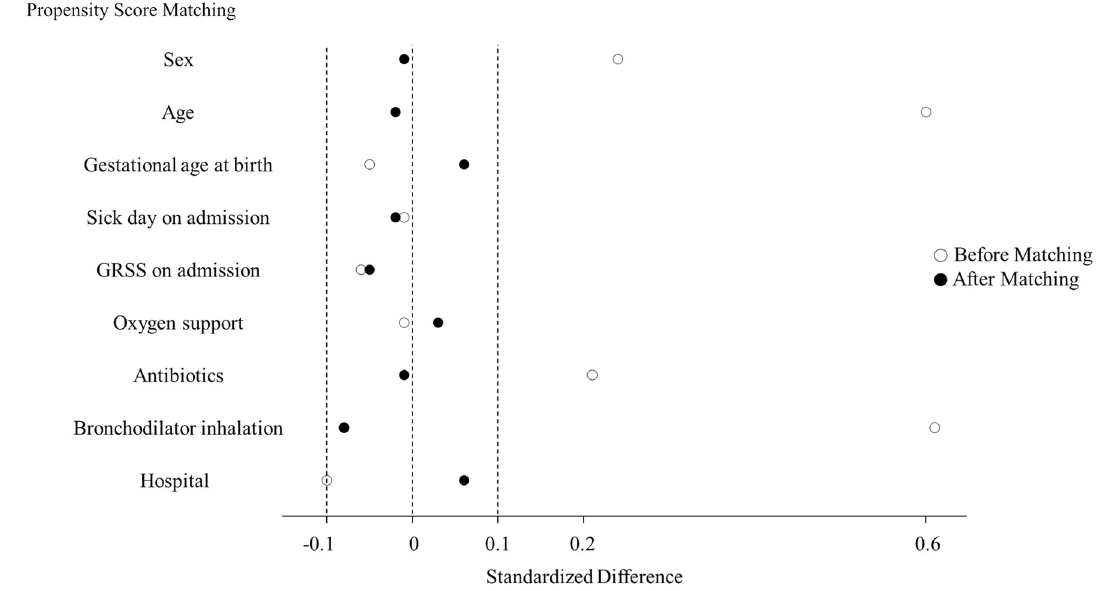
Fig 3. Covariate balance for propensity score matching of infants treated with and without pranlukast.